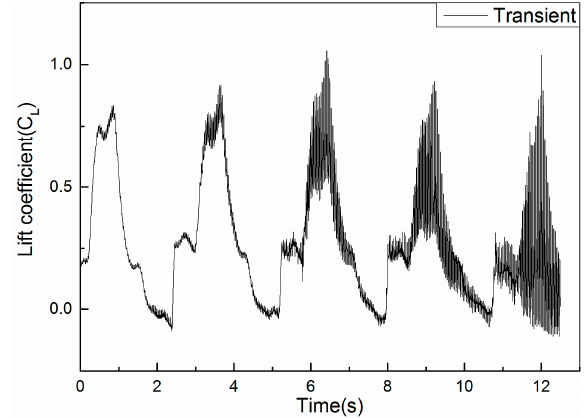
Figure 15. Time history of the wing lift coefficient calculated by the transient method.